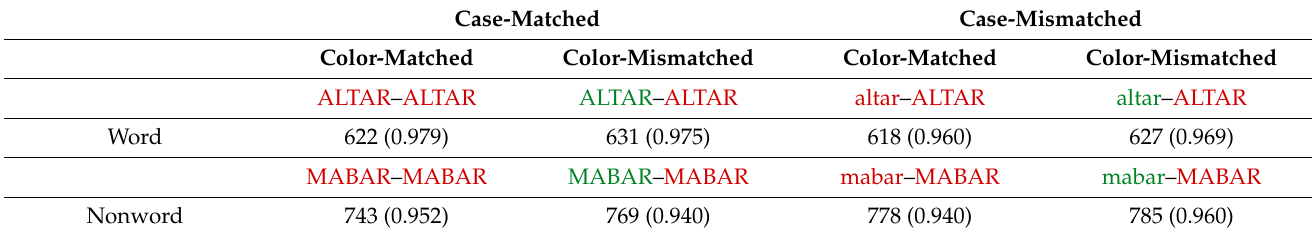
Table 1. Averages of the response times (in ms) and accuracy in each of the experimental conditions.